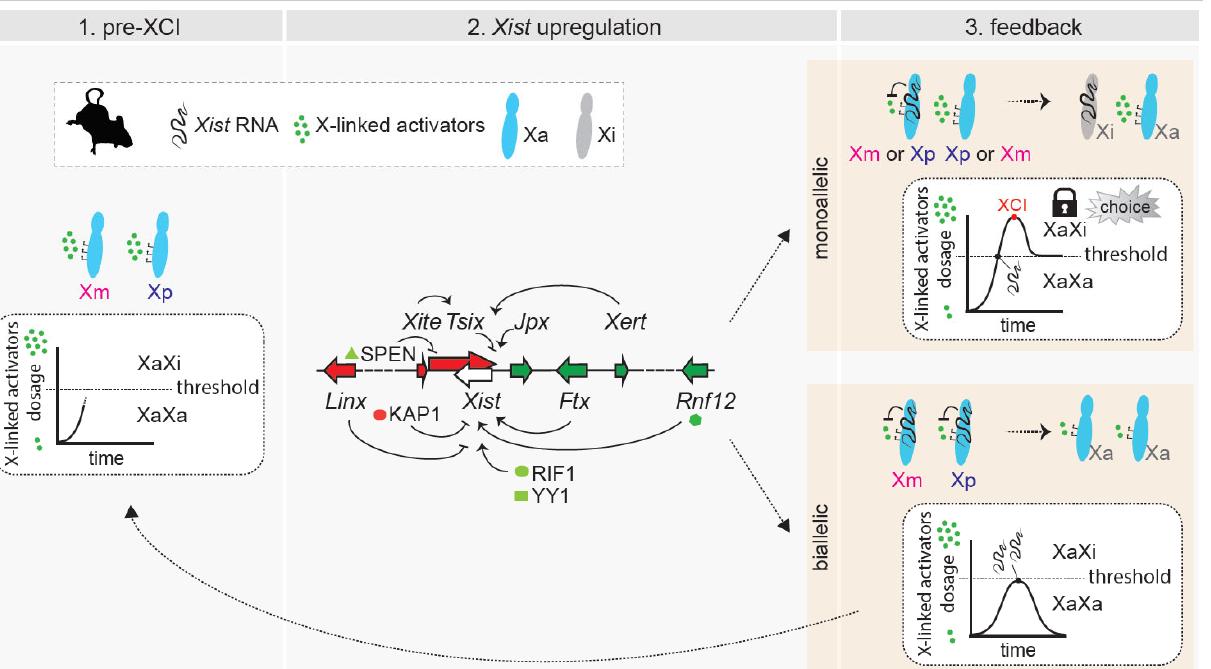
Figure 3. Dynamic model of choice during random XCI. ( Left ): Pre-XCI status. Both X chromosomes are active and transcribe X-linked genes. The dose of X-linked activators increases towards the threshold necessary for productive Xist upregulation. ( Middle ): Biallelic X-chromosome transcription allows the cell to reach the threshold for Xist activation. X-linked and autosomal cis and trans positive and negative regulators influence the initiation of Xist upregulation, which can